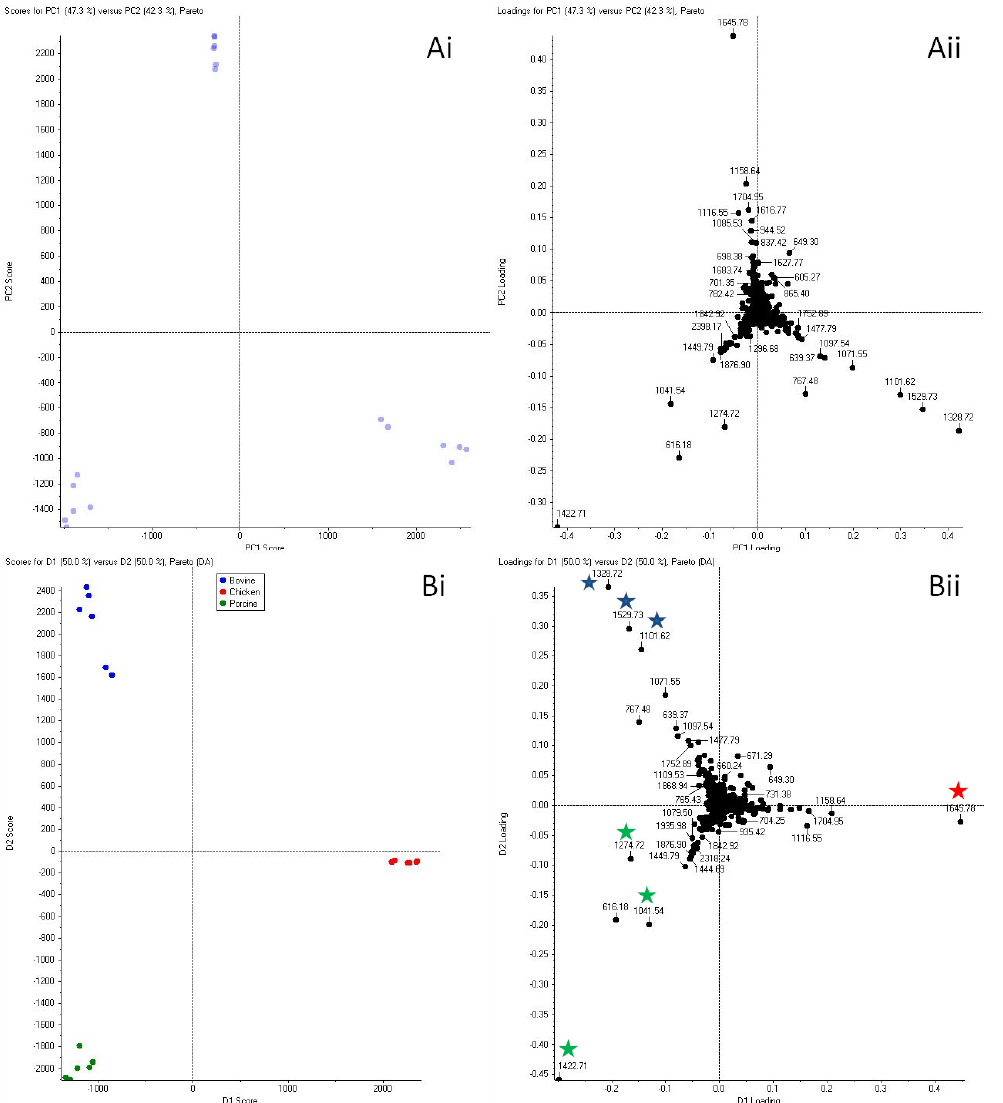
Figure 2. Principal component analysis of bovine, chicken and porcine blood collected from the jugular vein of the animal (“intravenous”). Six replicate spectra from each animal blood in solution proteolytic digests were used for PCA. Clear and distinct grouping can be observed with all three species in both the unsupervised ( Ai , Aii ) and supervised PCA-DA analyses ( Bi , Bii ). In ( Ai ), the purple dots on the scores plot are to show the variance and spatial relationship of the group replicates from an ‘un-supervised’, non-bias way hence no color has been pre-assigned to them. The unsuper- vised score plot in ( Ai ) clearly aligns with that of the supervised PCA-DA validating the rational for labelling. The star symbol in ( Bii ) indicates the ion signals subjected to MALDI MS/MS analysis. The colors in ( Bii ) refer to the animal species as color referenced in ( Bi